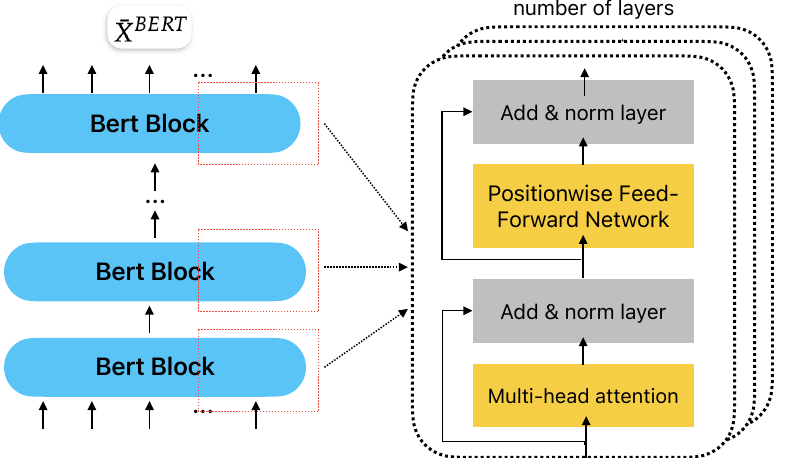
Figure 2. The architecture of encoder. The encoder is initialized based on multiple BERT blocks, each of which is composed of a multi-head attention and feed-forward